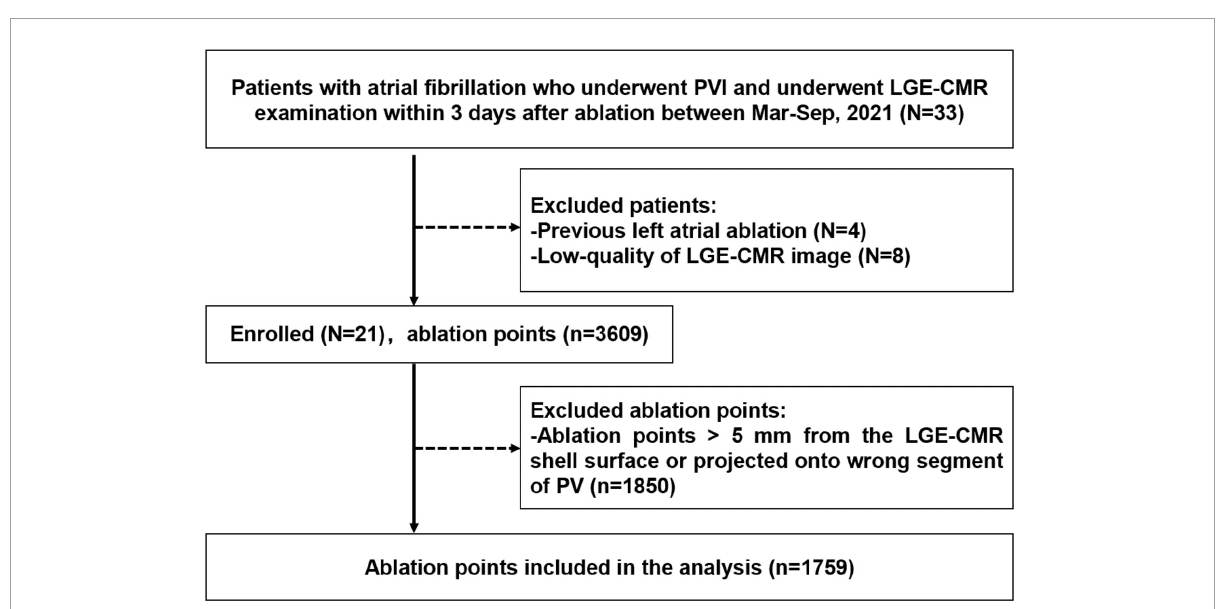
FIGURE1 Flow chart of the study design and outcome. PVI, pulmonary vein isolation; LGE-CMR, late-gadolinium enhancement cardiac magnetic resonance; Mar, March; Sep, September; PV, pulmonary vein.